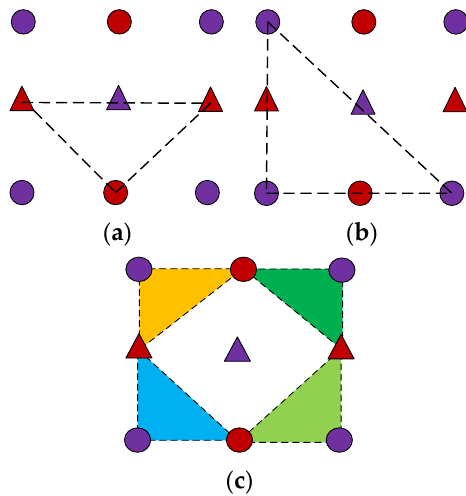
Figure 3. All possible triangles in the x neighborhood ( a ) down; ( b ) down and left (P); ( c ) mix.